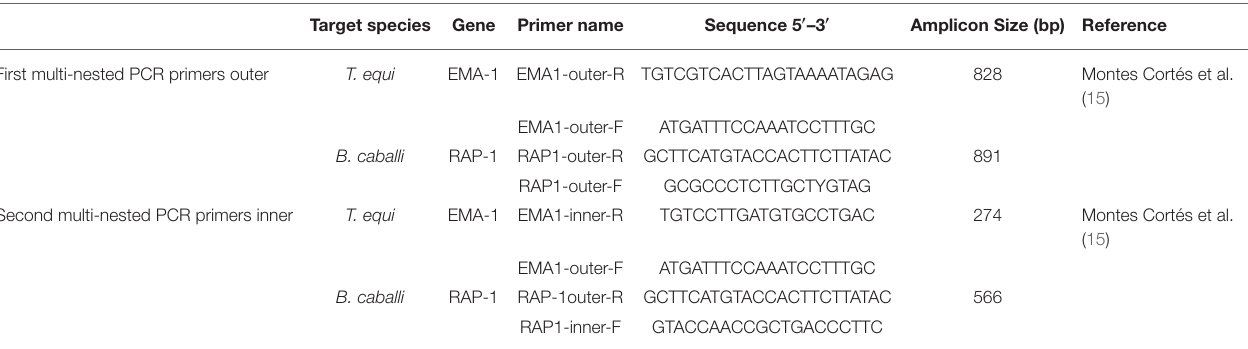
TABLE 2 | Primer sequences of multinested PCR for detecting T. equi and B. caballi .